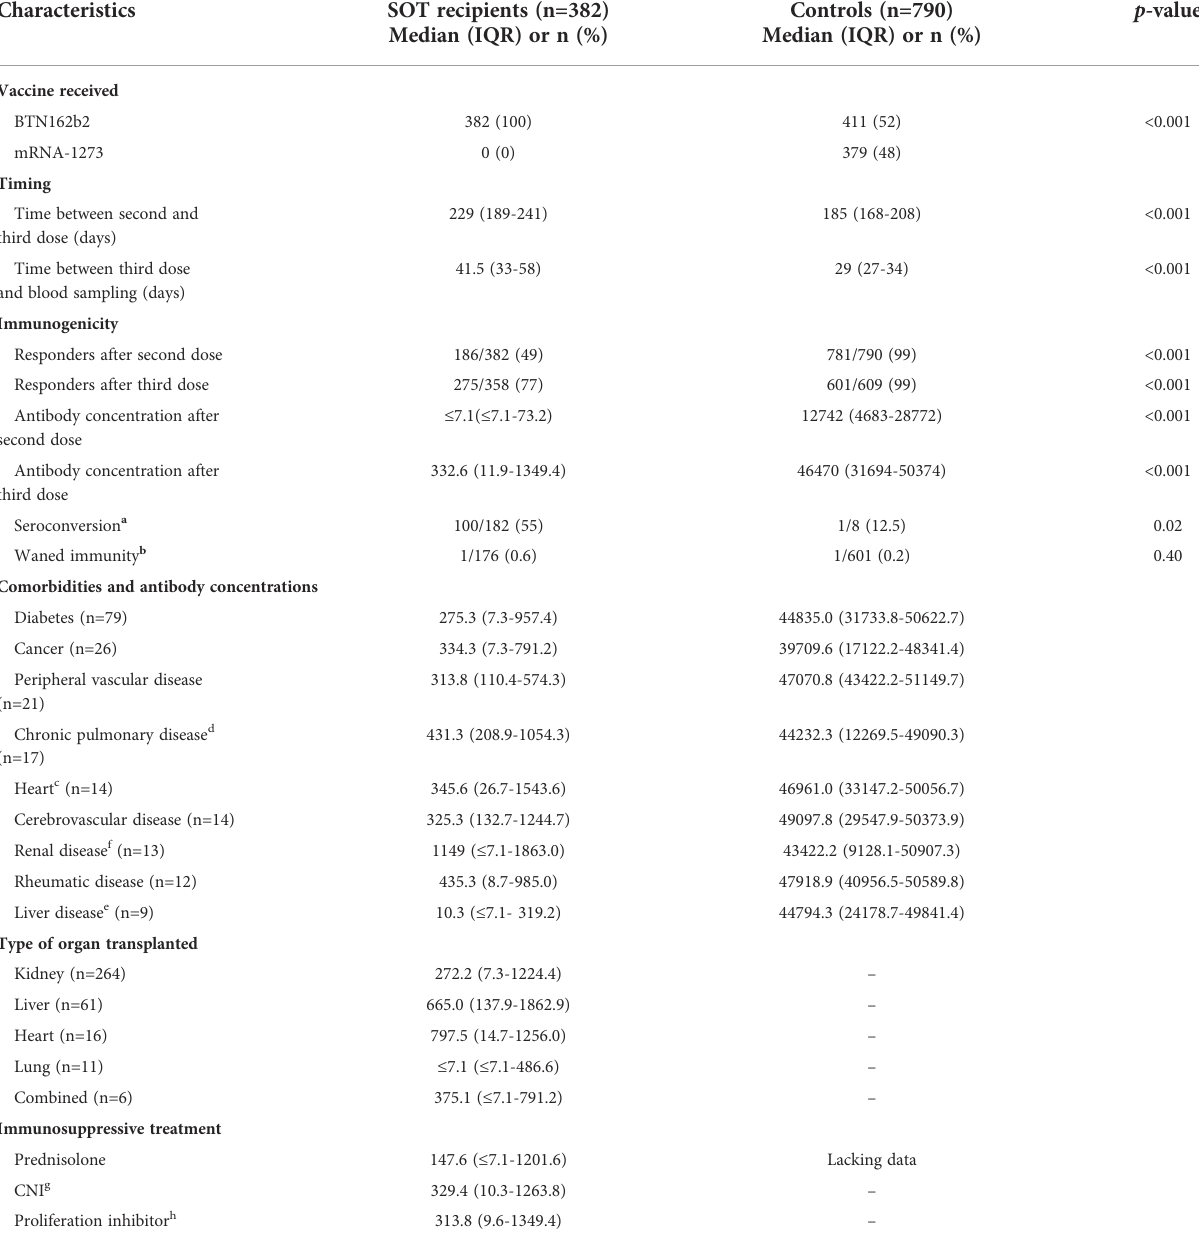
TABLE 2 Immunogenicity among solid organ transplant recipients and matched controls following a third dose of a SARS-CoV-2 mRNA vaccine.